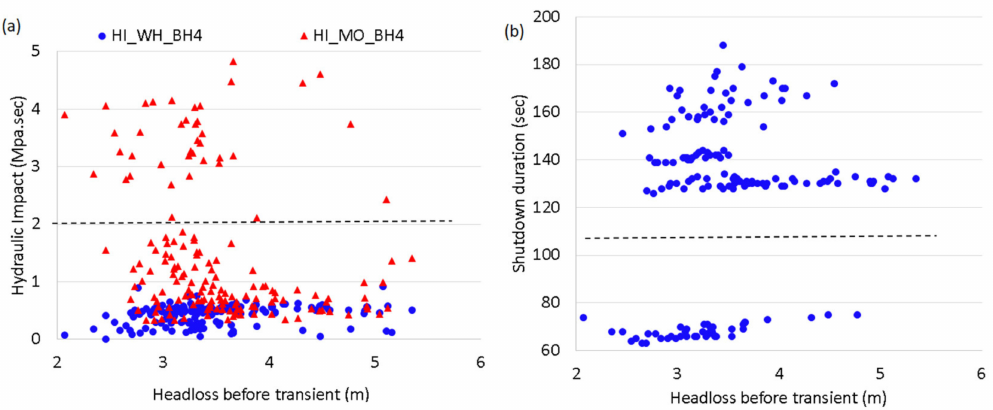
Figure 13. Hydraulic impact in relation to the magnitude of discharge change ( a ) and magnitude of discharge change vs. shutdown duration ( b ).